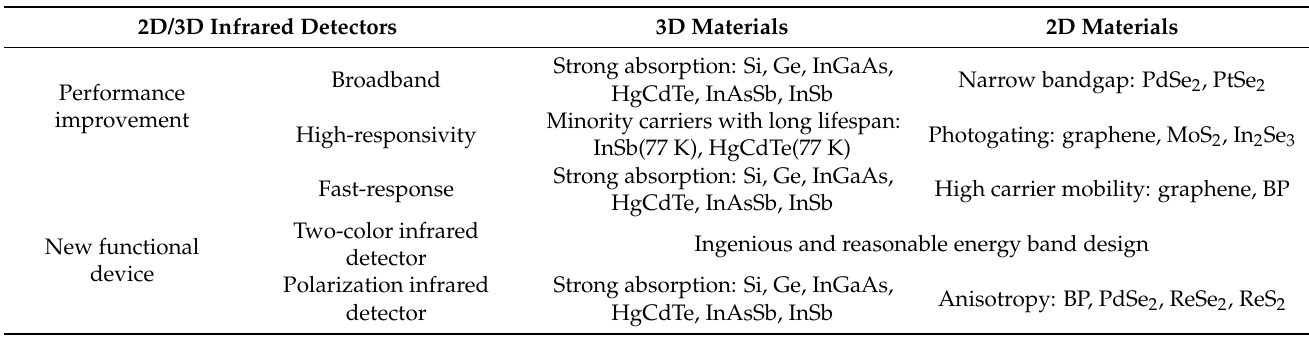
Table 1. Material selection for 2D/3D infrared